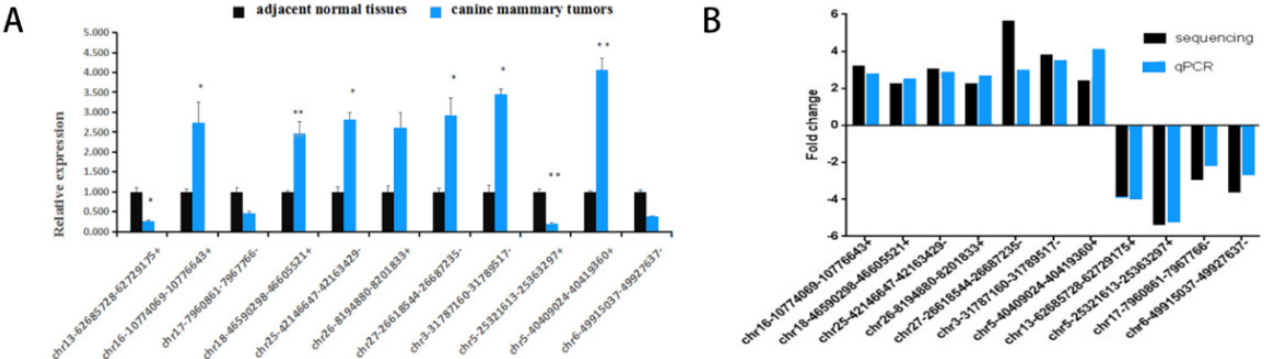
Figure 5. The molecular interaction of eight circRNAs and miRNAs. Yellow represents circRNAs, green represents miRNAs, and purple represents miRNA target genes.